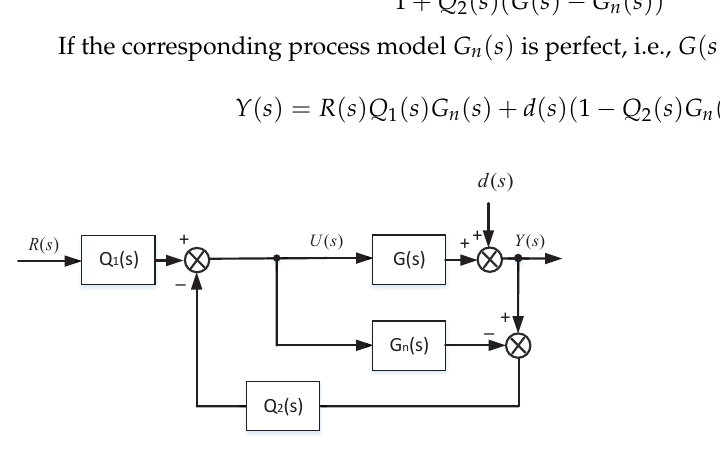
Figure 2. Principle block diagram of the 2DOF